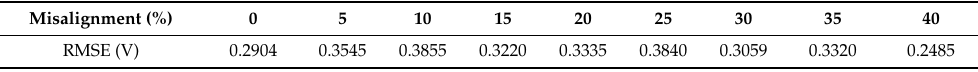
Figure 11. Output voltage tracking error in Case 2 with DC motor load, ( a ) PI control, and ( b ) FTSM- ELM control. Table 3. Performance evaluation under different alignments of two coils.